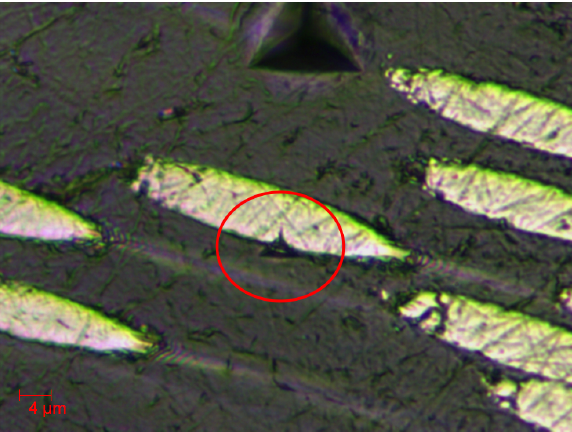
Figure 7. Image from the optical microscope of the broken fiber.